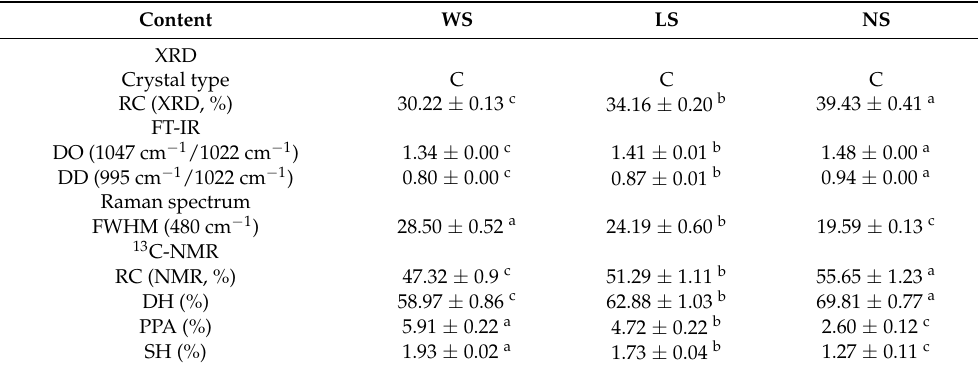
Table 3. Short-range molecular order and long-range crystalline structure of starch samples extracted by different